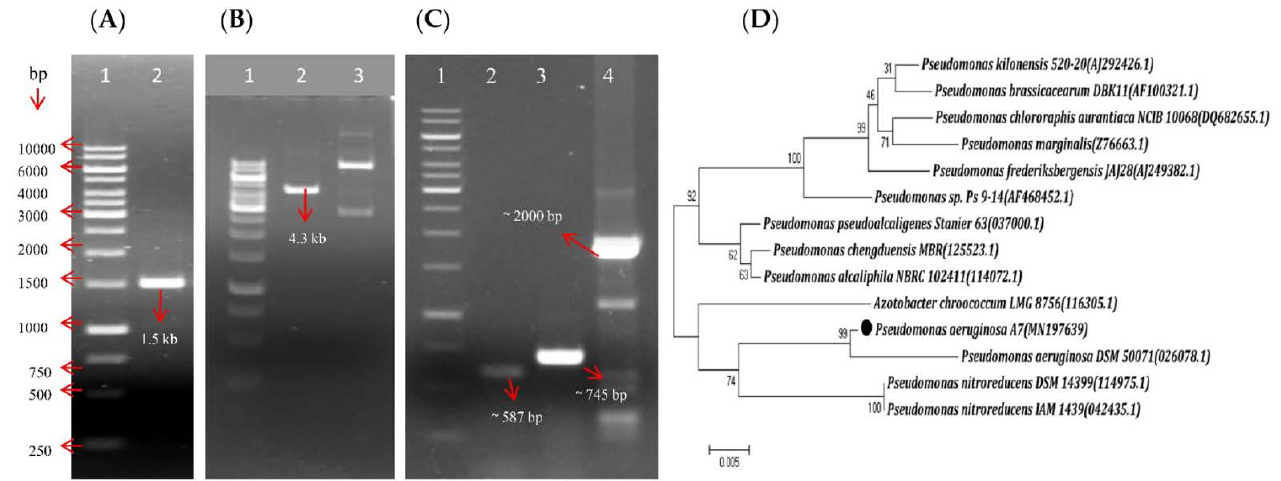
Figure 1. Molecular characterization of the bacterial strain A7. ( A ) Gel image of PCR amplified gene fragment [(lane 1 = Gene Ruler: 1 kb DNA Ladder; lane 2 = 16S rRNA gene fragment with 1.5 kb (kilo base)], ( B ) Gel image of EcoRI digested recombinant plasmid DNA fragment (lane 1 = Gene Ruler: 1kb DNA Ladder; lane 2 = digested 4.3 kb recombinant plasmid DNA fragment and lane 3 = undigested recombinant plasmid DNA, ( C ) Gel image of PCR amplified antifungal antibiotics gene fragments (lane 1 = Gene Ruler: 1 kb DNA Ladder; lane 2 = gene fragment hcnBC with approx. 587 bp (base pairs); lane 3 = gene fragment phlD with approx. 745 bp, lane 4 = gene fragment phzH with approx. 2000 bp) and ( D ) Phylogenetic tree analysis of the strain A7 ( Pseudomonas aeruginosa strain. Values are given at branch nodes and are based on 1000 replicates. The scale bar